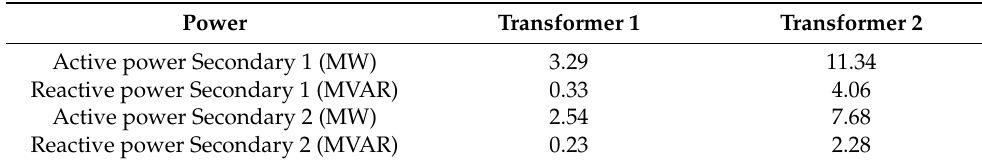
Table 2. Active and reactive power